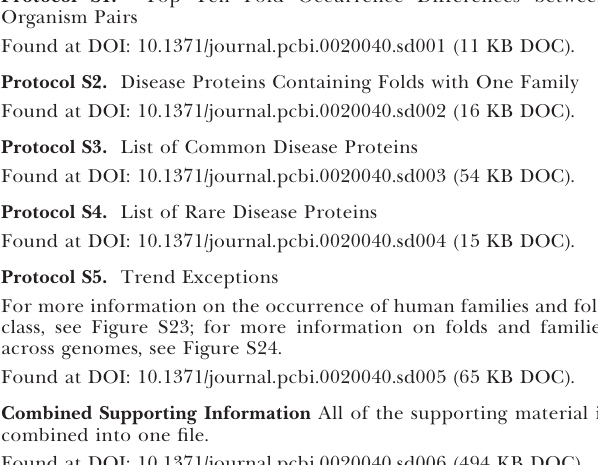
Figure S18. Sequence Divergence and Fold Age